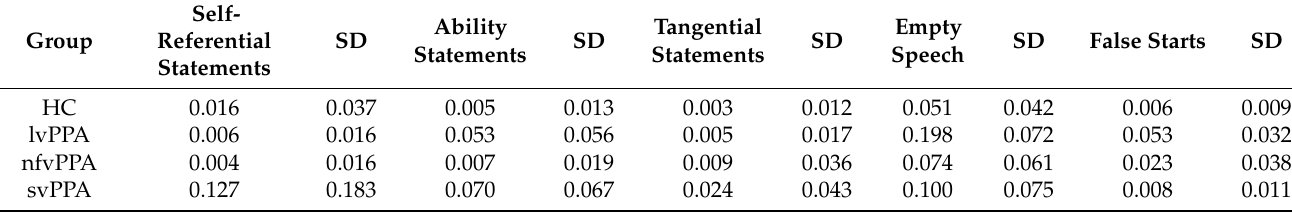
Table A3. The proportion of self-referential and other off-topic or empty